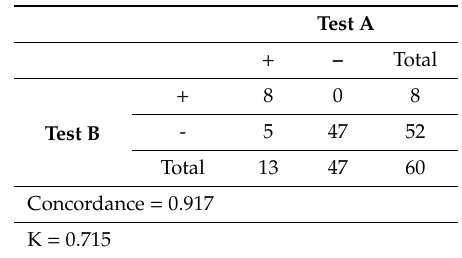
Table 2. Concordance of the methods using Cohen’s kappa coe ffi cient. (Test A: Amplification refractory Sanger sequencing).